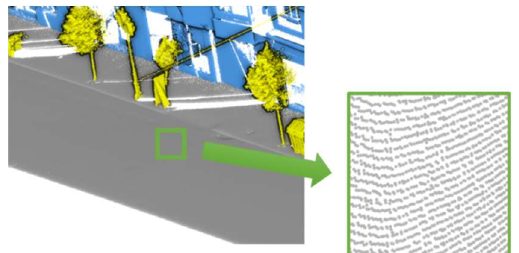
Figure 1: Zoom in on scan patterns of a street acquired with